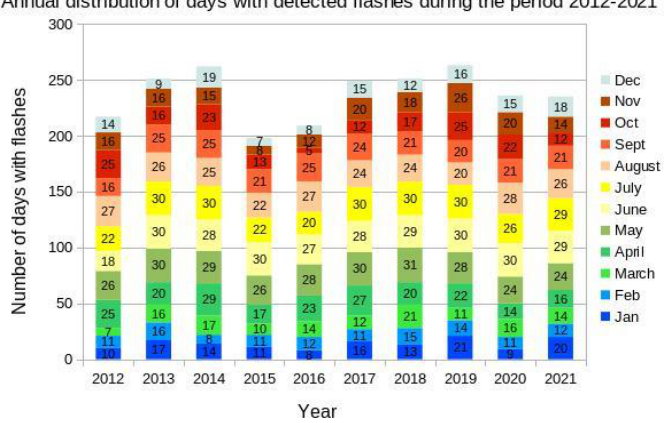
Figure 3. Annual distribution of the number of days with flashes detected by ATDnet over the studied domain for the period 2012–2021.